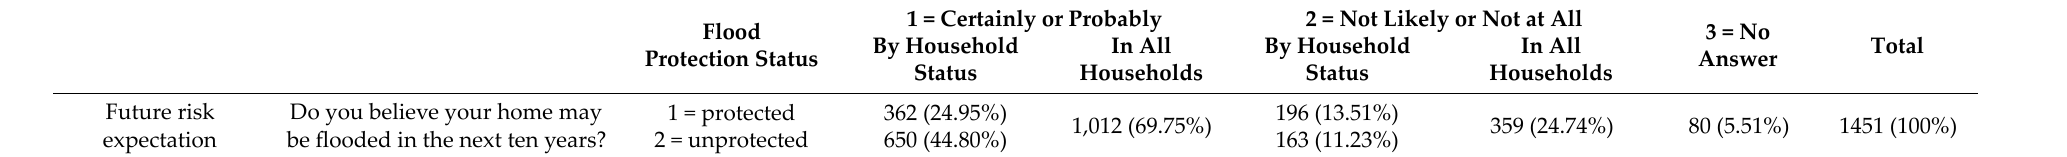
Table 3. Future flood risk assessment among